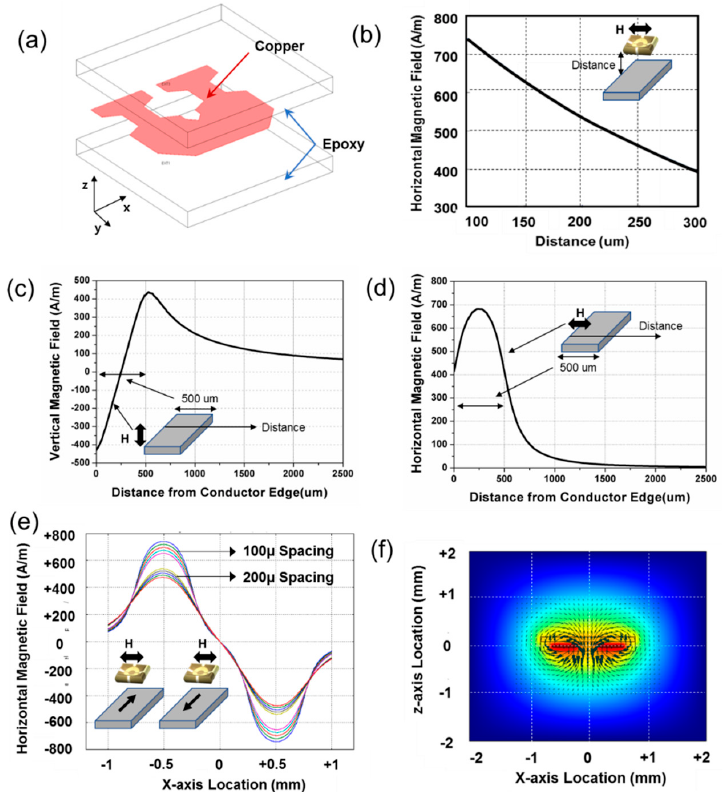
Figure 3. ( a ) The pattern of the current-flowing conductor line, ( b ) a simulated magnetic field distribution image around the conductor lines. ( c ) Vertical magnetic field and ( d ) horizontal magnetic field according to the distance between the PHR sensor and the conductor line, and ( e ) horizontal magnetic field according to the distance between the conductor line and a sensor. ( f ) Horizontal magnetic field of two conductor lines in opposite current direction.